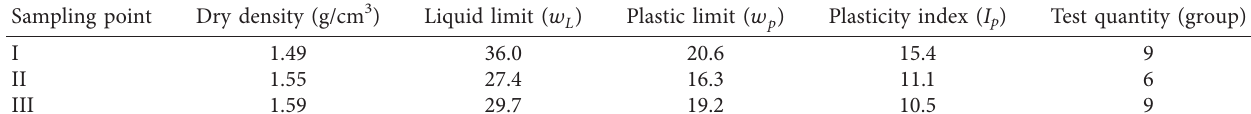
Figure 11: Location and distribution of sampling points. Table 1: Basic information on sampling points.